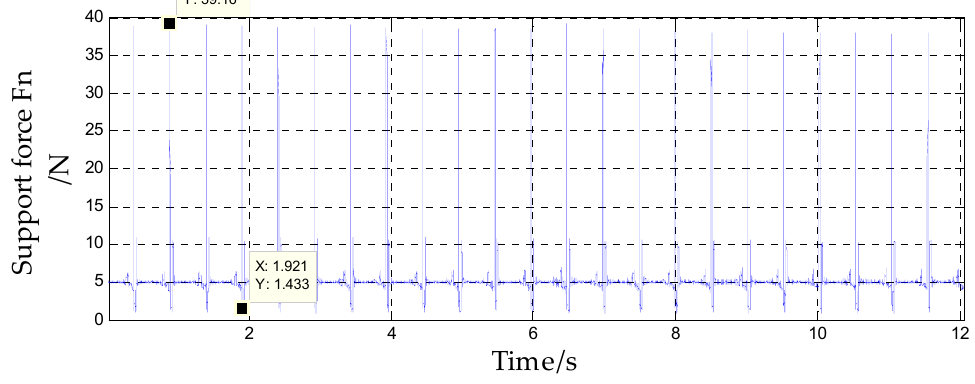
Figure 17. Support force of the isolated rolling